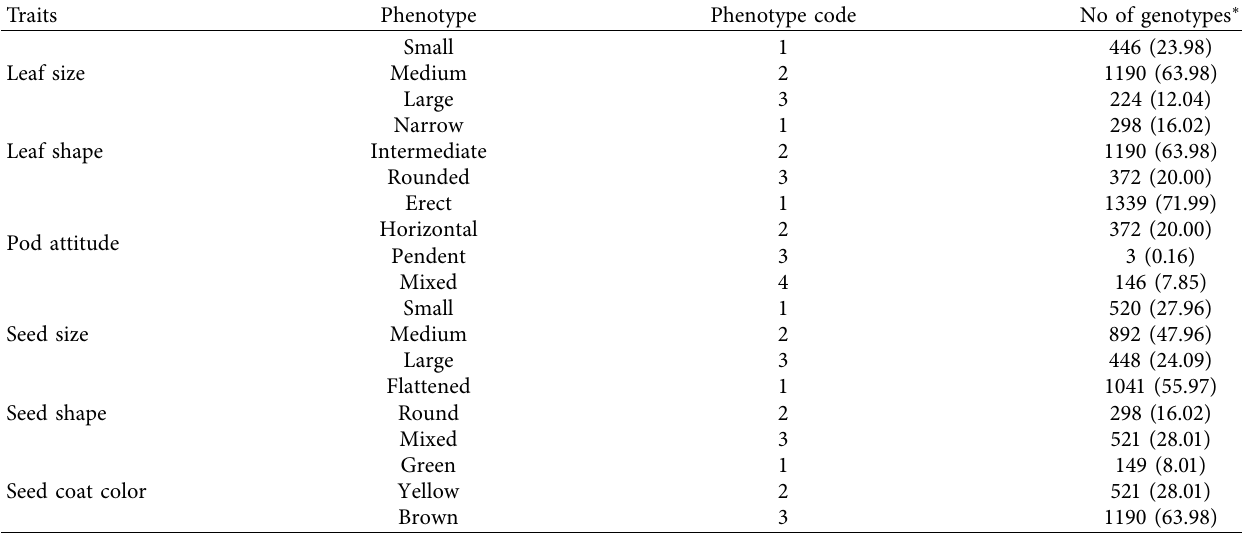
Table 5: Qualitative traits used in the study along with their phenotype, phenotype code and number or frequency of genotypes. Traits Phenotype Phenotype code No of genotypes